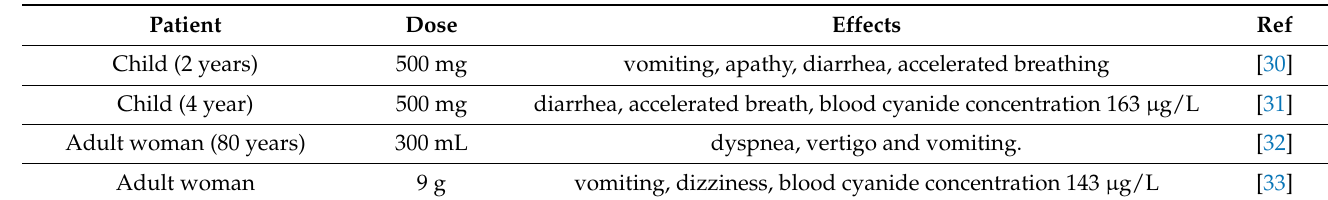
Table 3. Information on amygdalin